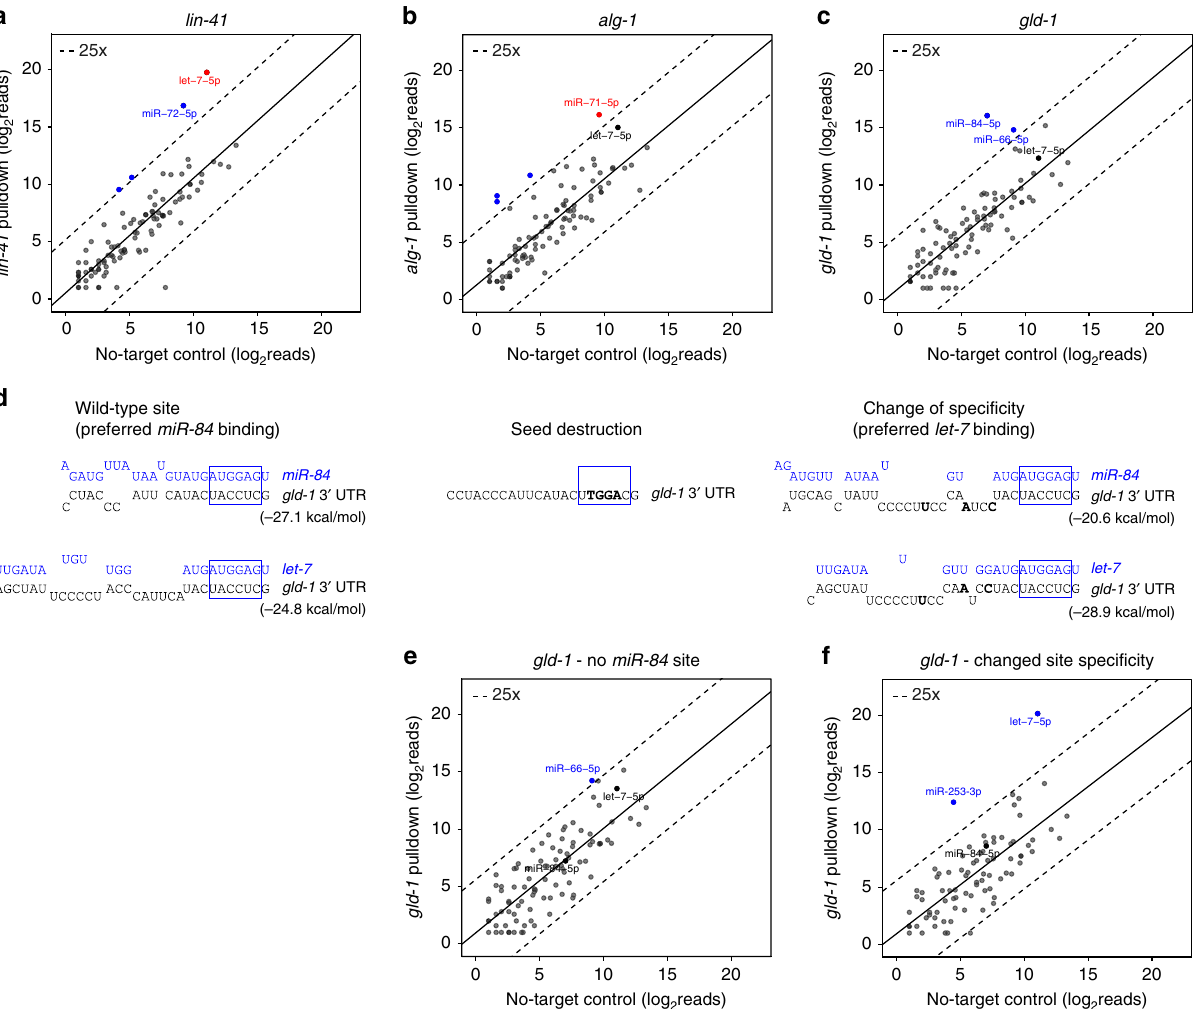
Fig. 5 vIPR allows identi fi cation of transcript-speci fi c miRNAs. a – c vIPR identi fi es miRNAs that speci fi cally enrich versus no-target control (blue dots) for endogenous lin-41 ( a ), alg-1 ( b ), and gld-1 ( c ) transcripts. Known interactions are colored in red. Plotted are miRNAs found in both target and no-target pulldown. Solid line: linear regression of log 2 -transformed reads. d Base-pairing predictions (RNAhybrid 45 ; version 2.2) for the miR-84 and let-7 miRNAs with the gld-1 3 ′ UTR. Edits introduced by CRISPR to either abrogate miR-84 binding (seed destruction) or to convert the miR-84 site into a let-7 binding site (change of speci fi city) are shown as bold nucleotides. The blue boxes highlight the miRNA seed. e Editing of the let-7 family seed complement leads to abrogation of miR-84 binding. f Editing of seed-distal bases results in abrogation of miR-84 binding and enrichment of the let-7 miRNA upon gld-1 pulldown. For each target, one replicate of two independent pulldown experiments is shown. See also Supplementary Data 6 for miRNA